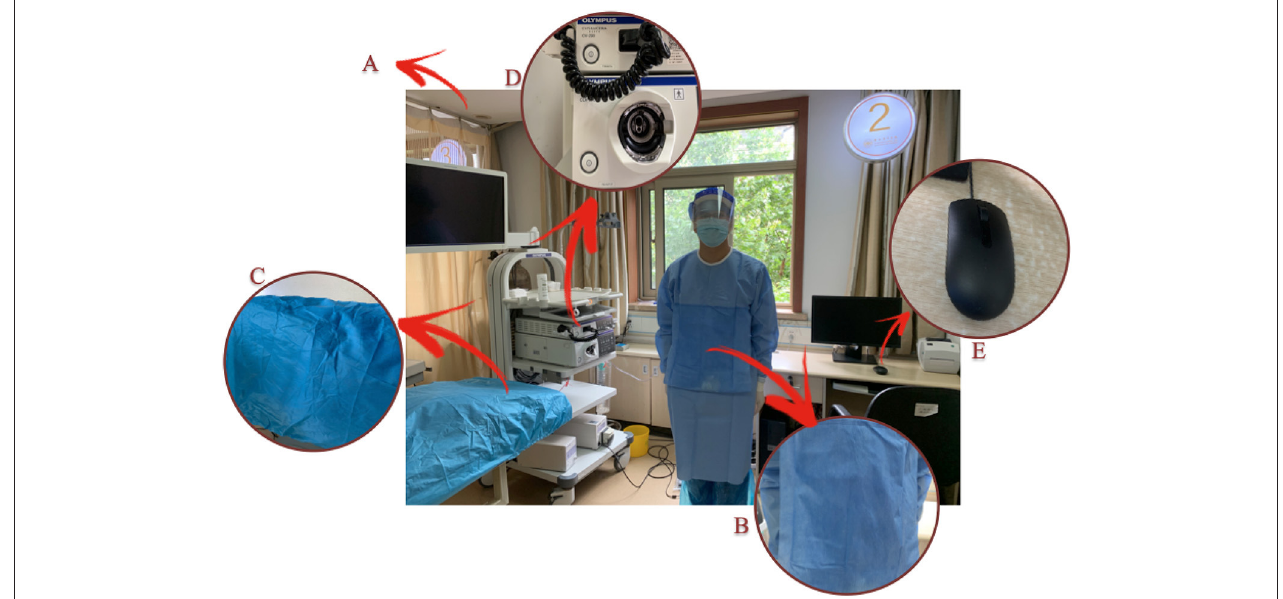
FIGURE 4 | The number of culture samples in the level of CFUs for the surface of the endoscopy unit between sedation and nonsedation gastroscopy. (A) operation unit air; (B) isolation gown of the endoscopist; (C) workstation mouse; (D) control panel buttons; and (E) bed head of the